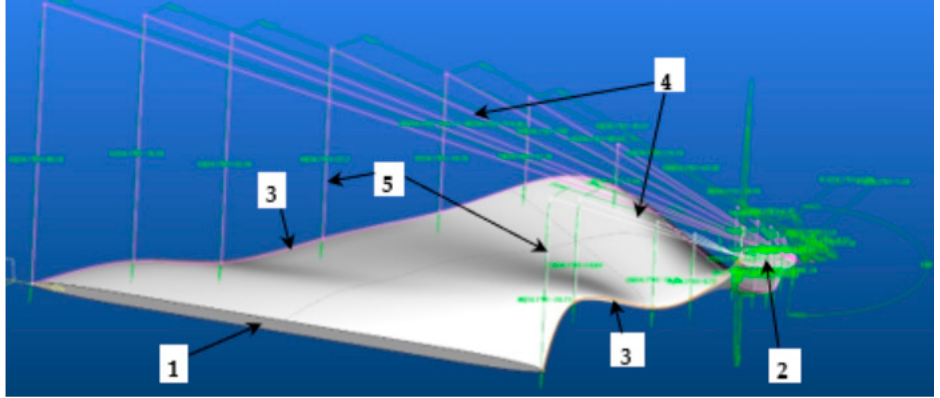
Figure 12. The scapula spine with acromion process.